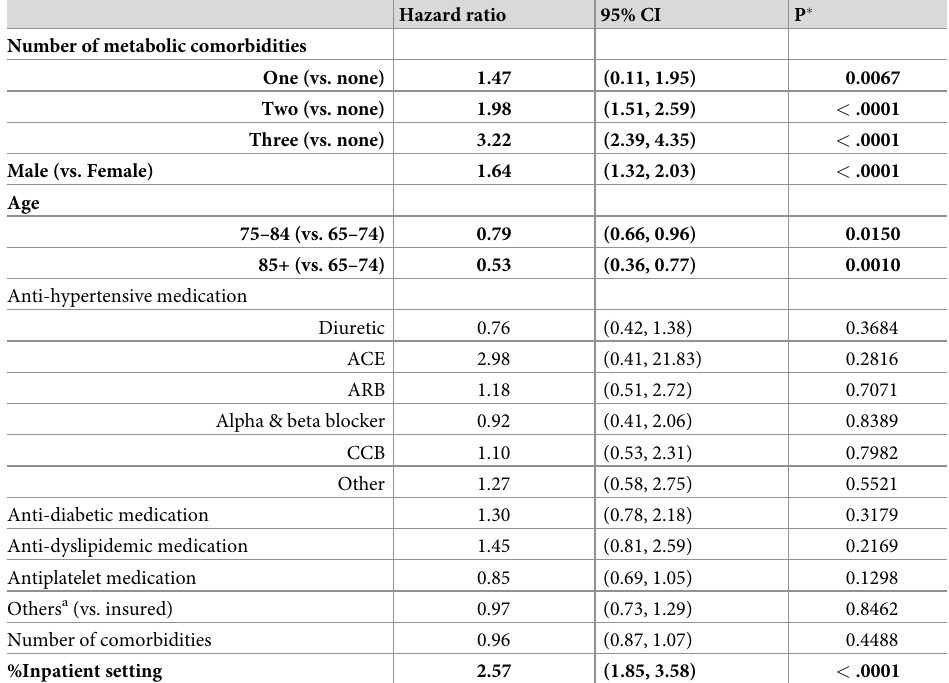
Table 5. Association of MALE with number of metabolic comorbidity groups (n = 3,122). Hazard ratio 95% CI P � Number of metabolic comorbidities One (vs. none) 1.47 (0.11, 1.95) 0.0067 Two (vs. none) 1.98 (1.51, 2.59) < .0001 Three (vs. none) 3.22 (2.39, 4.35) < .0001 Male (vs. Female) 1.64 (1.32, 2.03) < .0001 Age 75–84 (vs. 65–74) 0.79 (0.66, 0.96) 0.0150 85+ (vs. 65–74) 0.53 (0.36, 0.77) 0.0010 Anti-hypertensive medication Diuretic 0.76 (0.42, 1.38) 0.3684 ACE 2.98 (0.41, 21.83) 0.2816 ARB 1.18 (0.51, 2.72) 0.7071 Alpha & beta blocker 0.92 (0.41, 2.06) 0.8389 CCB 1.10 (0.53, 2.31) 0.7982 Other 1.27 (0.58, 2.75) 0.5521 1.30 (0.78, 2.18) 0.3179 1.45 (0.81, 2.59) 0.2169 (0.69, 1.05) 0.1298 0.8462 0.4488 %Inpatient setting 2.57 <